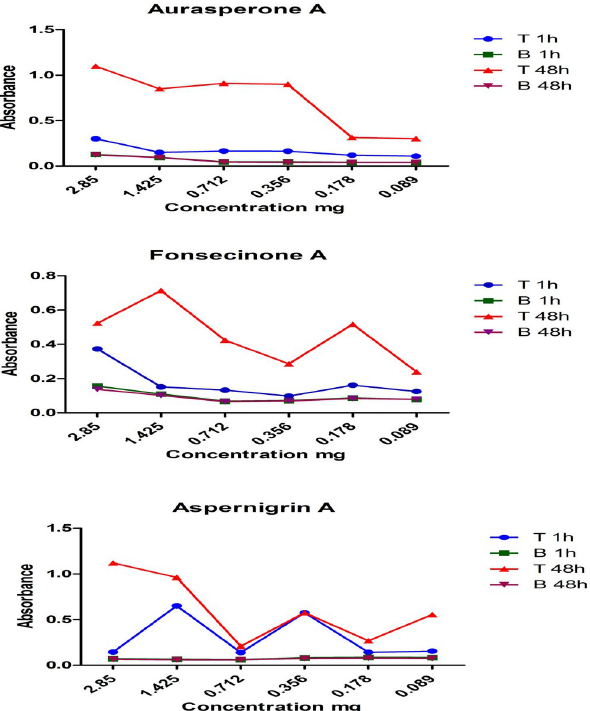
Fig 4. UV absorbance of compounds aurasperone A, fonsecinone A and aspernigrin A upon addition of AgNO 3 solution after 1 h. and after 48 h.